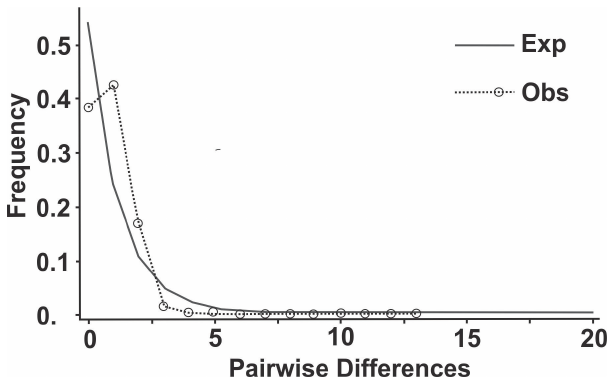
Fig. 4. Mismatch distribution for mitochondrial haplotypes for 92 individuals of Brycon nattereri from the Laranjinha